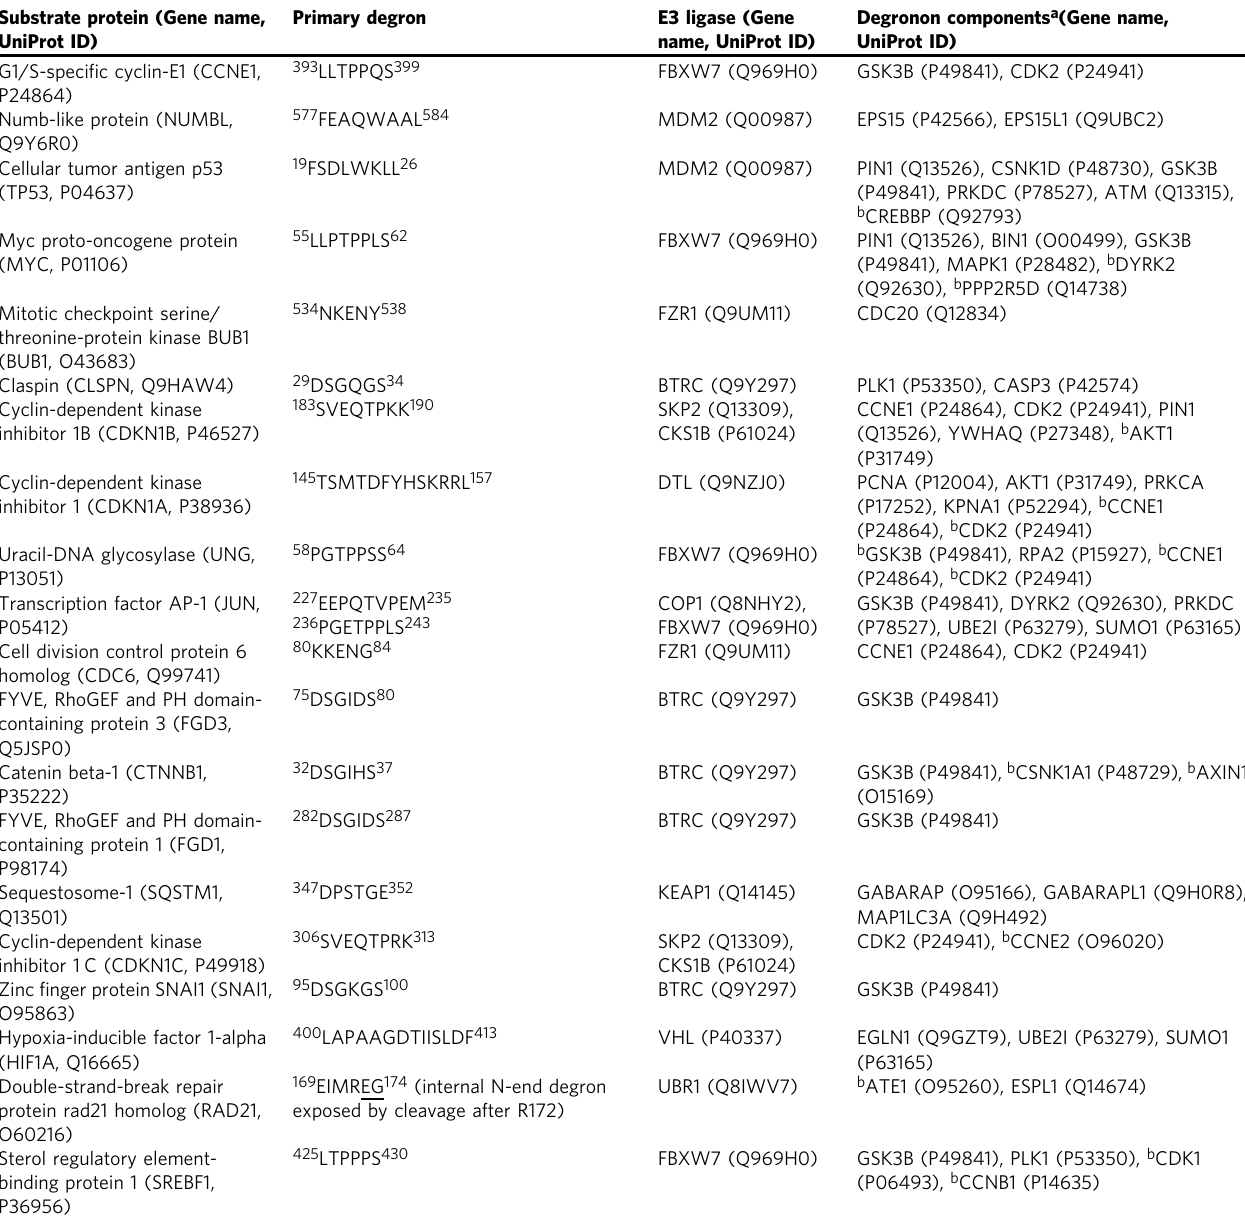
Table 1 Selected human degradation substrates, their corresponding E3 ligases (or the adaptor subunit, in case of multi-subunit E3s) and degronon